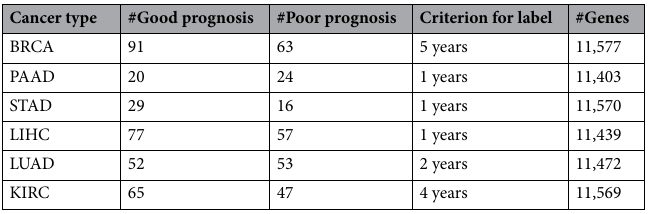
Table 1. Descriptions of mRNA data for each cancer type.